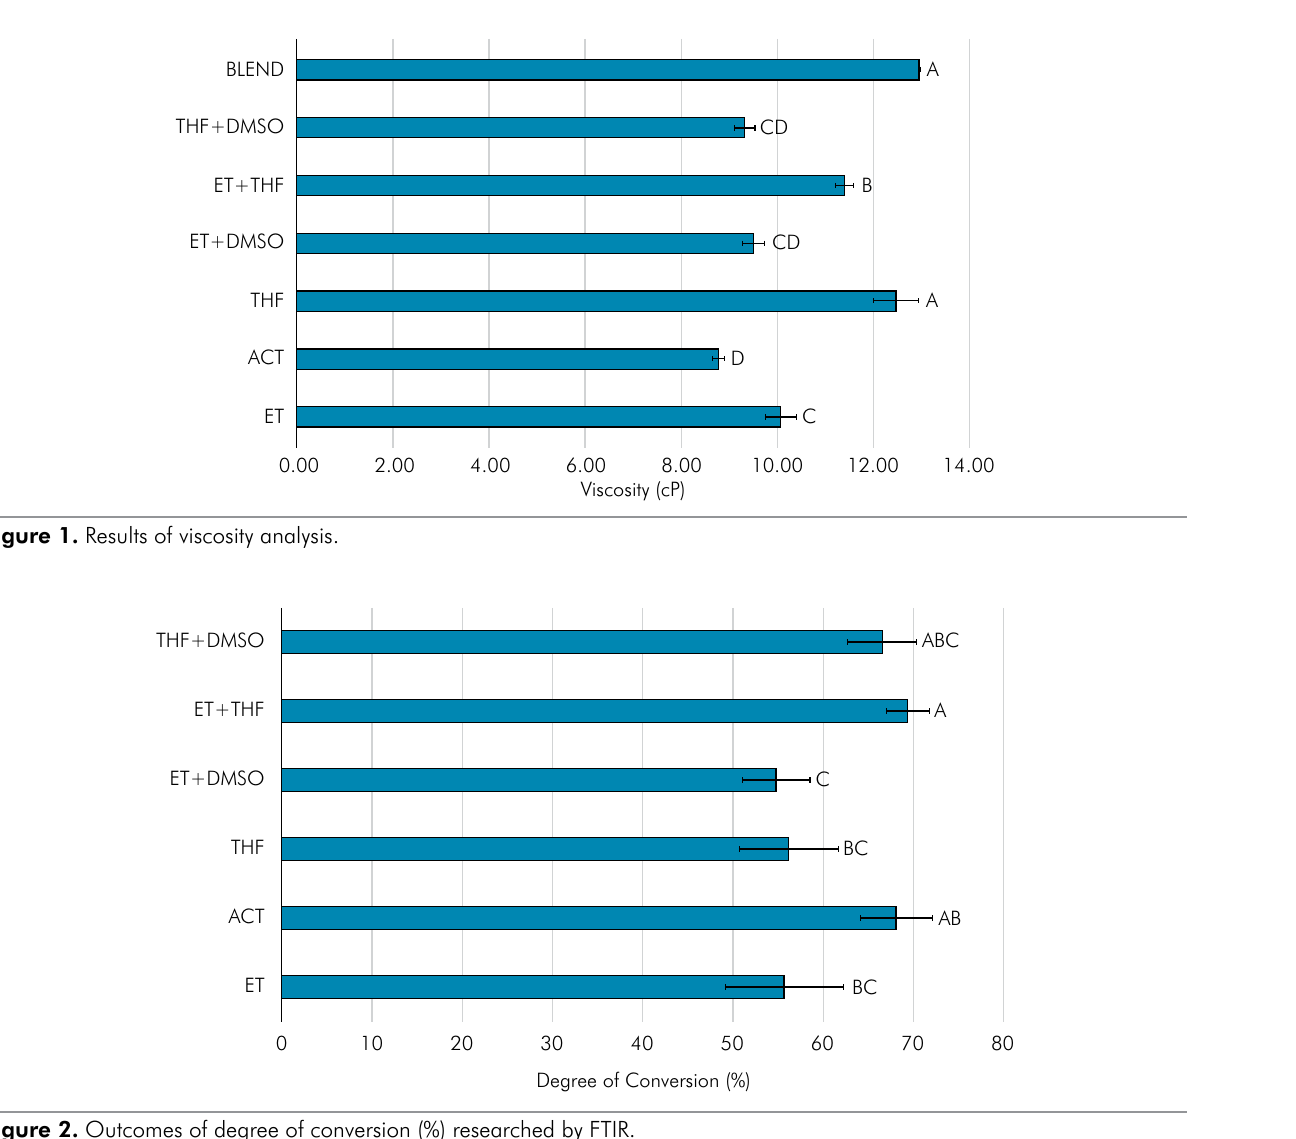
Figure 2. Outcomes of degree of conversion (%) researched by